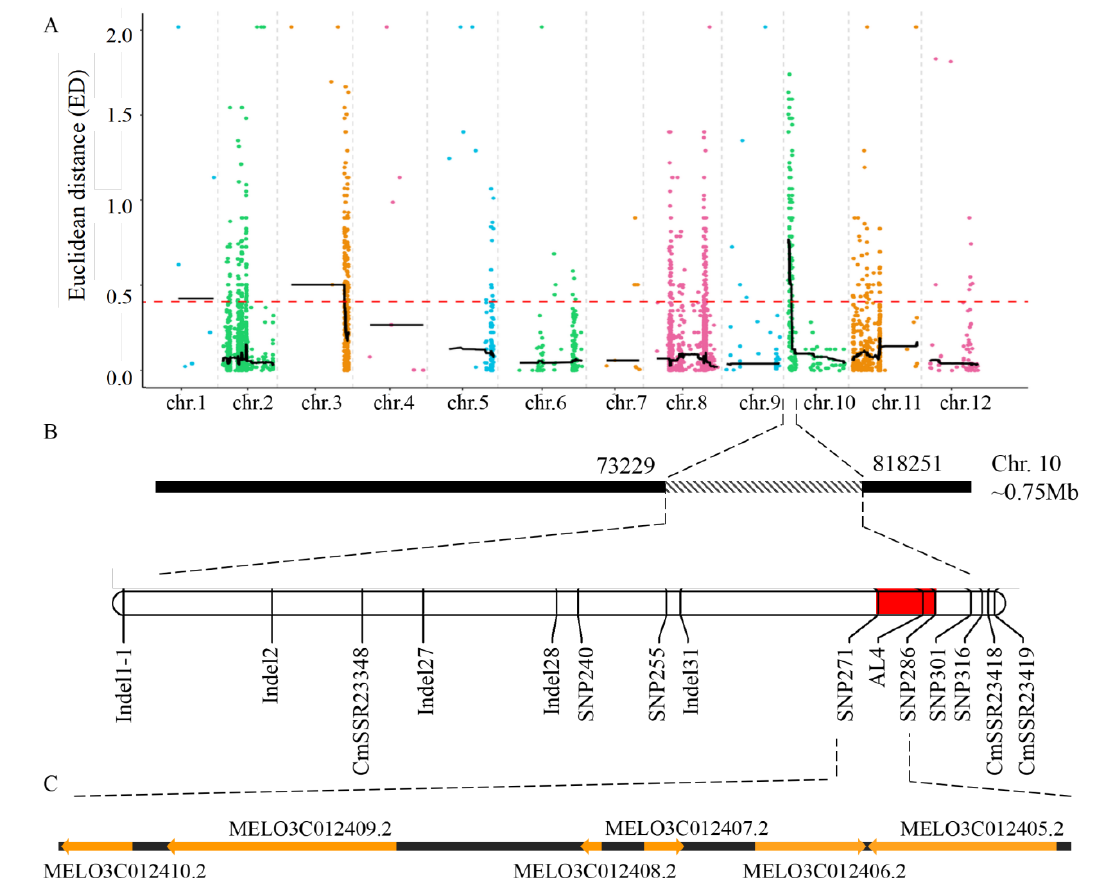
Figure 2. Mapping of candidate genes for MAF. ( A ): Primarily mapping of mfa10.1 using SLAF-BSA technology by F 3 -57 family, which is a single gene segregation population. ( B ): narrow mapping of the candidate region in chromosome 10, and more than 14 molecular markers were used to narrow the candidate region by another 352 F 3 -57 individuals plants. ( C ): Finally, the candidate gene was located between SNP271 and SNP286, which spanned the 35 Kb region containing contains 6 candidate genes.